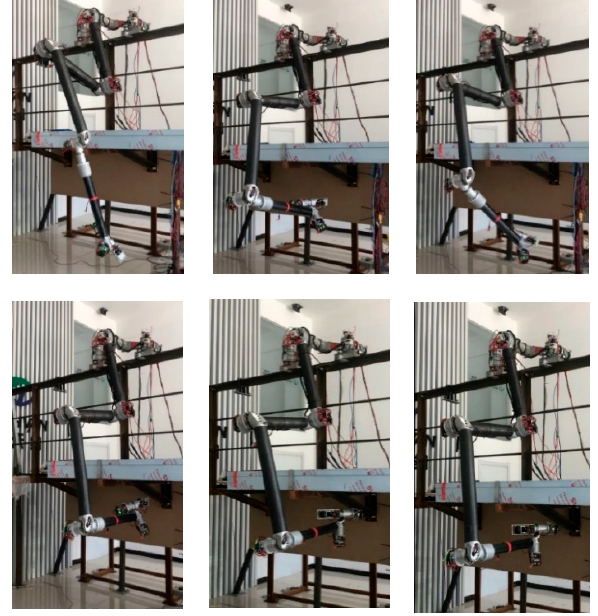
Figure 26. Snapshots of the redundant manipulator experiment.